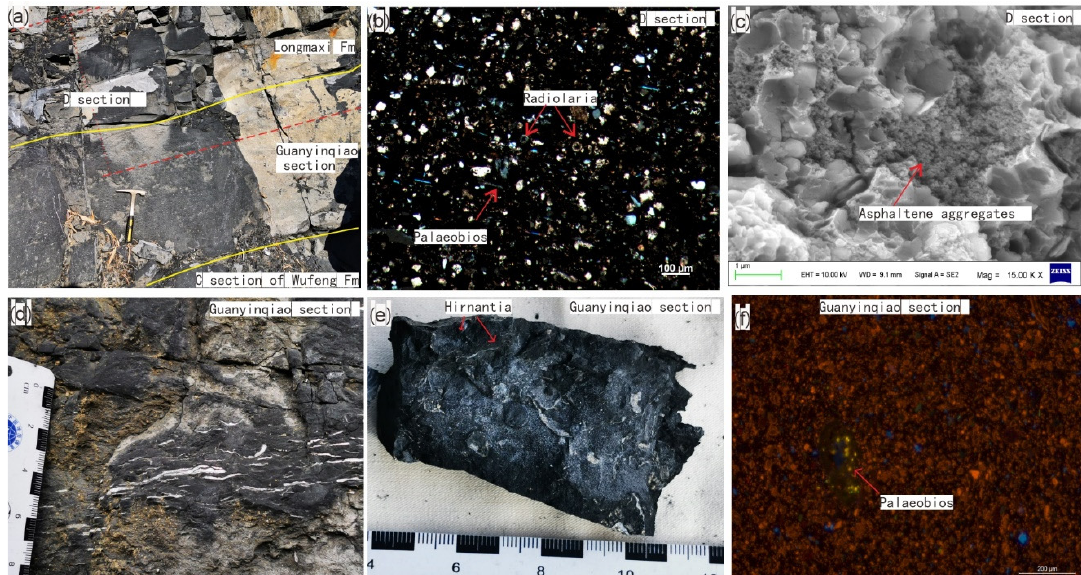
Figure 3. Mineral, rock and biological characteristics of the Wufeng and Longmaxi Fm. ( a ) outcrop characteristics, photo; ( b ) mineral and biological characteristics of Section D of Longmaxi Fm, thin section photo; ( c ) quartz and organic matter in Section D of Longmaxi Fm, SEM; ( d) bioclastic lime- stone of Guanyinqiao Fm, photo; ( e ) Hirnantia of Guanyinqiao Mem, photo; ( f ) biological features of Guanyinqiao Mem of Wufeng Fm, Cathodoluminescence photo.